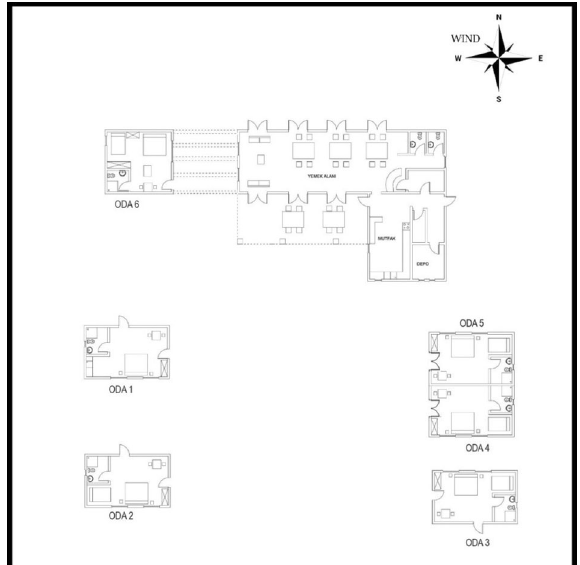
Fig. 11 Glaro Garden Hotel. Plan sketch — Risokarpaso.